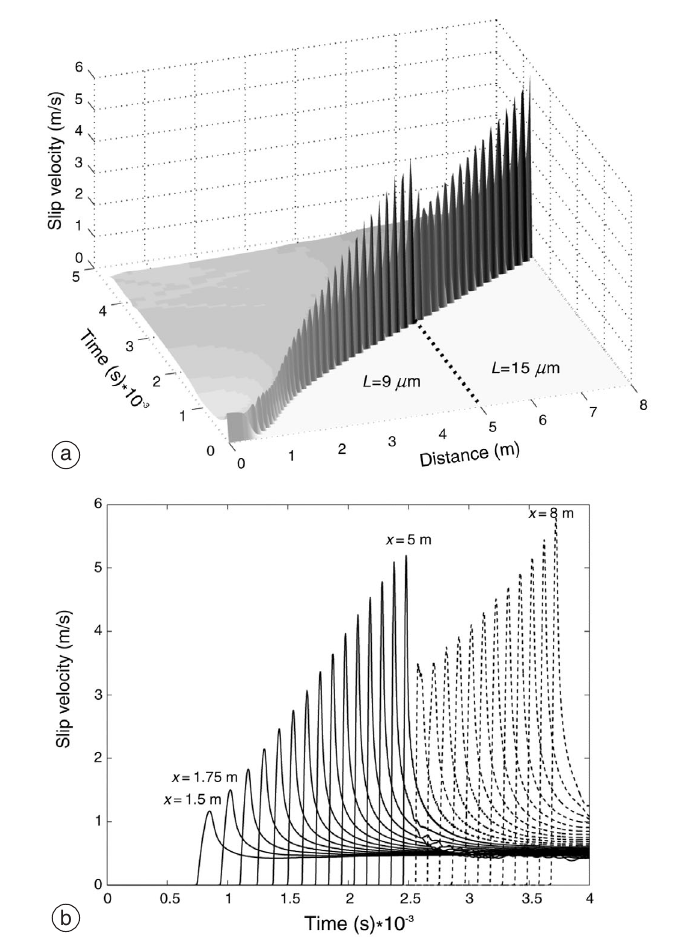
Fig. 5a,b. Dynamic rupture propagation along a heterogeneous fault: the adopted constitutive parameters are listed in table III. The fault is represented as two patches having different values of the L parameter ( L 1 and L 3 in table III): the external one has a larger value (1.6 times the inner one). Panel a) shows the spatio-temporal evo- lution of slip velocity. Panel b) displays the time histories of slip velocity in different positions along the fault: solid lines identify slip velocity computed for points located in the inner region (low L ), while dashed lines iden- tify slip velocity computed for those points located in the external region (high L